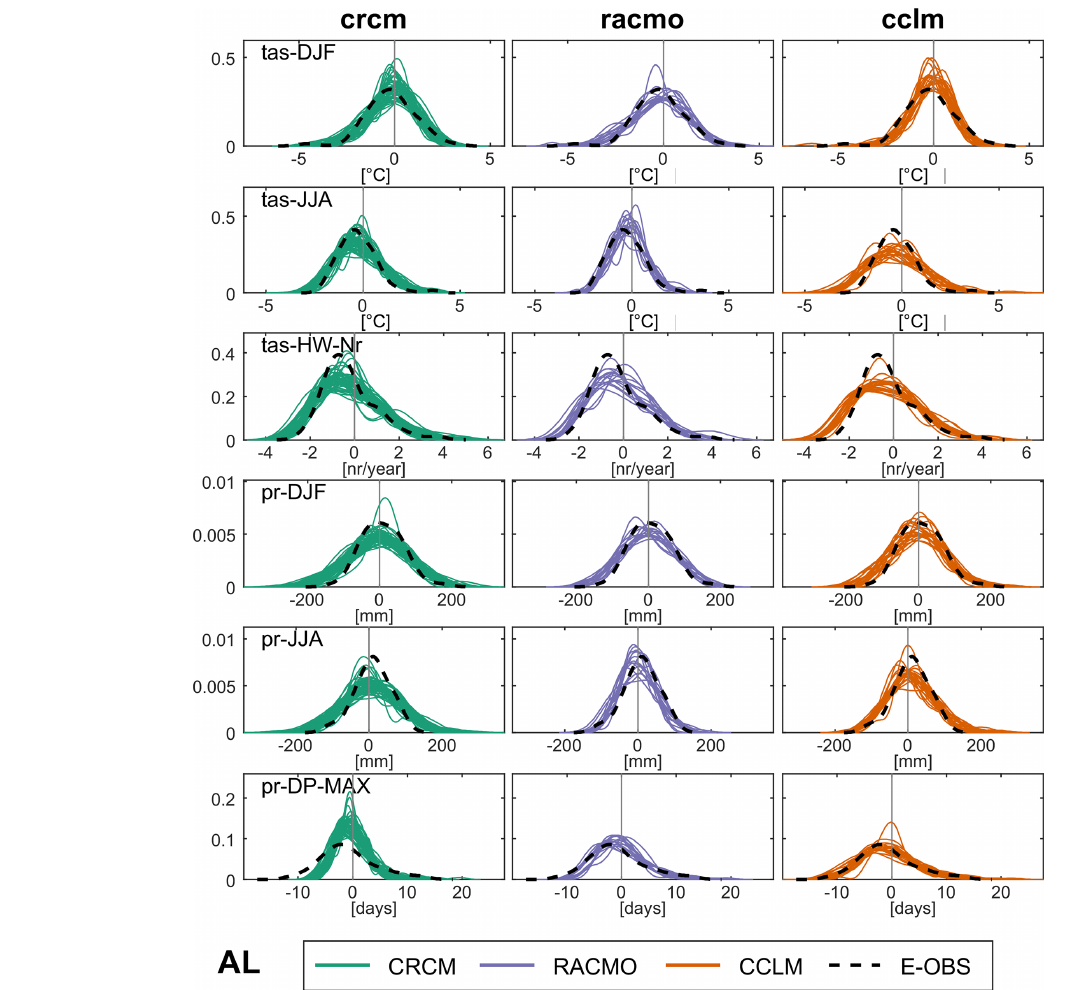
Figure 6. Probability density functions of the annual anomalies for all six indicators in the Alps (AL). For details, see Fig.